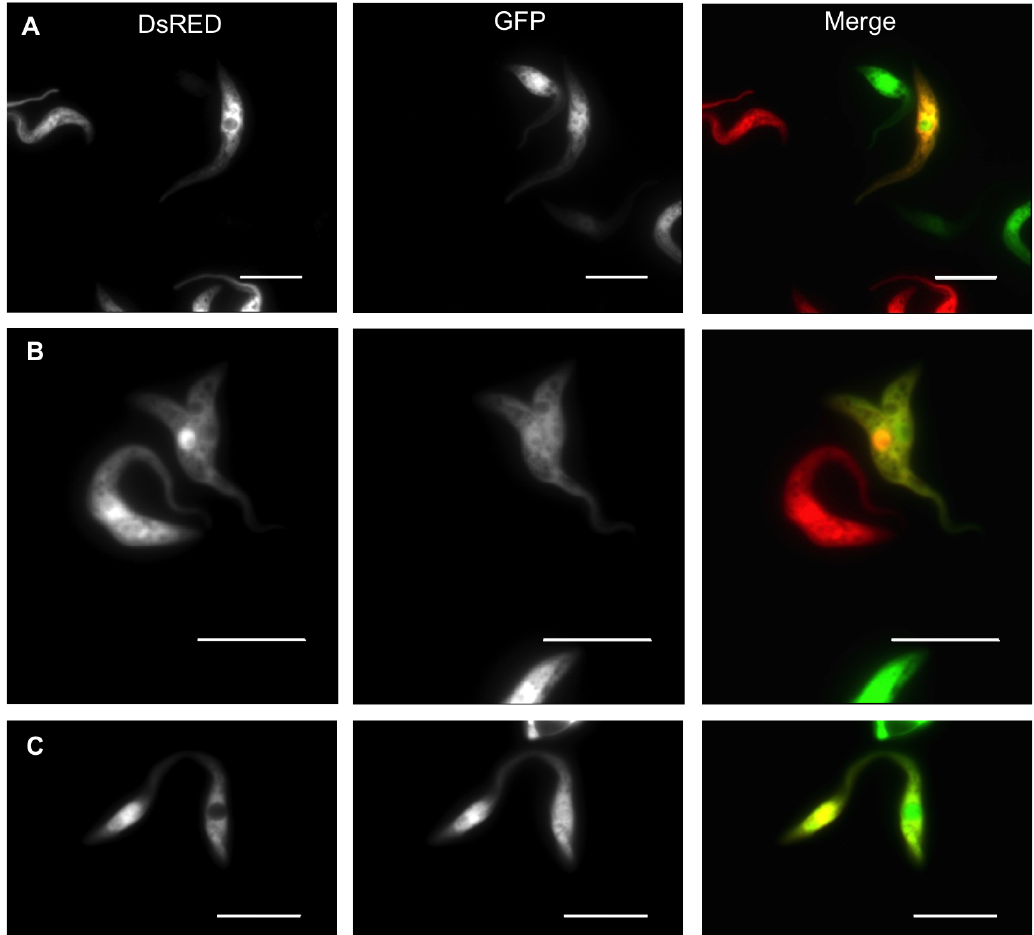
Figure 1. Fluorescence microscopy of co-cultured trypanosomes expressing DsRED or GFP. A : Double-positive trypanosome after 24 hours co-culture (WT). B : Interacting double-positive trypanosome pair found after 24 hours co-culture ( Δ proc). C : Double-positive trypanosomes connected at their anterior ends ( Δ proc). The scale bar indicates 10μm. DsRed tends to accumulate in the nuclei of cells that synthesise it, probably because of its propensity to form